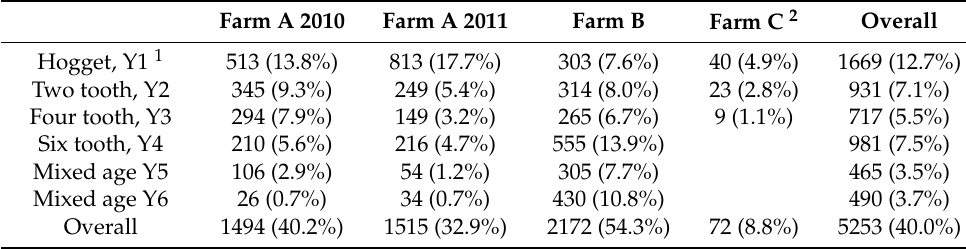
Table 3. Number (and %) of total enrolled ewes that exited due to dead/missing during each year of the study, for each study cohort, and as an